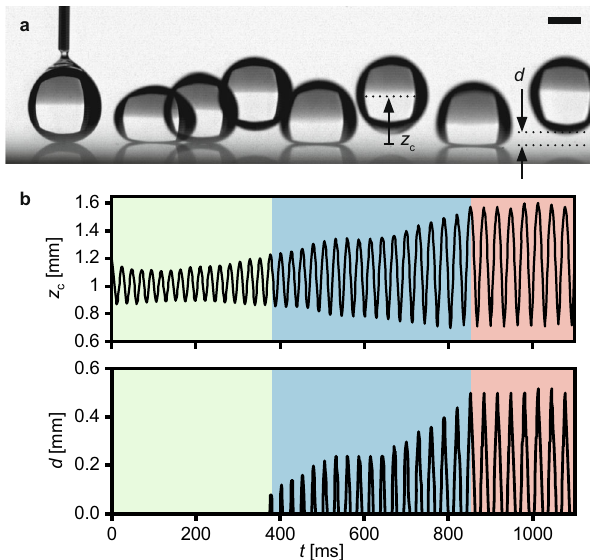
Fig. 1 Leidenfrost droplet trampolining. a Side-view chronophotographic image of a water droplet gently deposited on a fl at silicon wafer heated to a temperature of T S = 251 °C. For the case in ( a ), we quantify the droplet motion and show in ( b ) plots of its centroid position, z c , and the visible vapor cushion thickness between the droplet and the heated surface, d , vs. time, t , respectively. After deposition, the droplet is in a Leidenfrost state and z c oscillates with increasing amplitude (green section in ( b )). After a few oscillations, the droplet performs its fi rst jump so that a visible gap between the droplet and the heated surface appears. During the successive jumps, the droplet gains height, and the maximum gap height during a jump increases (blue section in ( b )), until the droplet reaches jumping heights of 0.5 mm (red section in ( b )). Over the course of the observation, the droplet slowly moves laterally on the surface (Supplementary Movie 1). Time-zero is when the droplet detaches from the needle. The time steps of the chronophotography in ( a ) are 600 ms between the fi rst and the second frame and 80 ms for all subsequent frames. The initial droplet radius is 1.1 mm. The scale bar represents 1 mm. Source data are provided as a Source Data fi